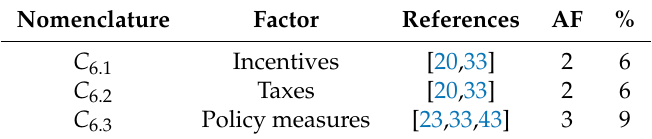
Table 12. Political Category ( C 6 )—Onshore wind energy. Quantitative analysis.